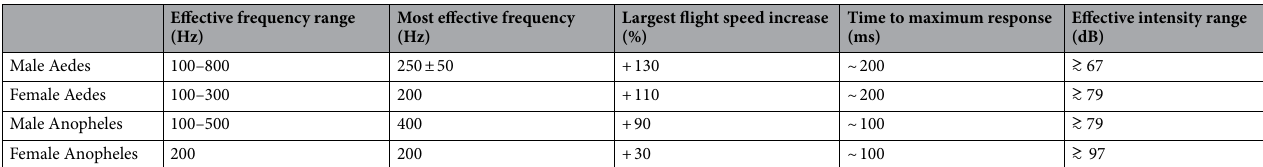
Table 1. Summary of the acoustotactic response of A. aegypti and An. gambiae